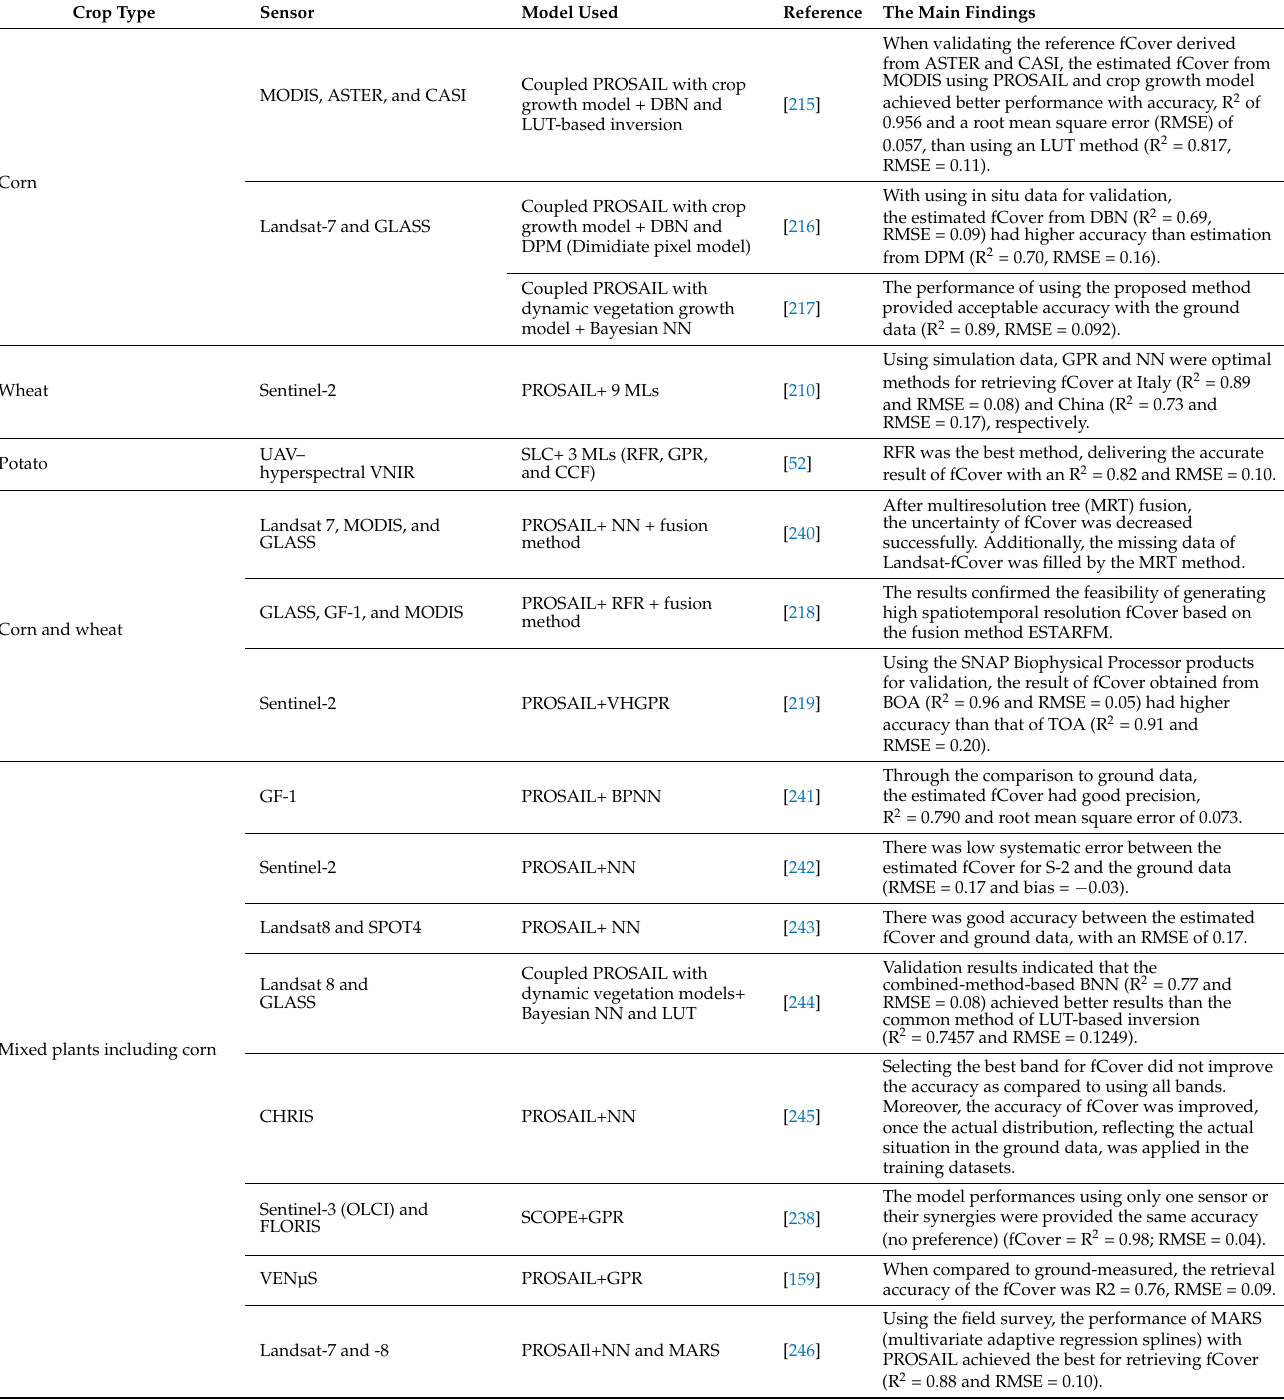
Table A5. Summary of fCover prediction using nonparametric